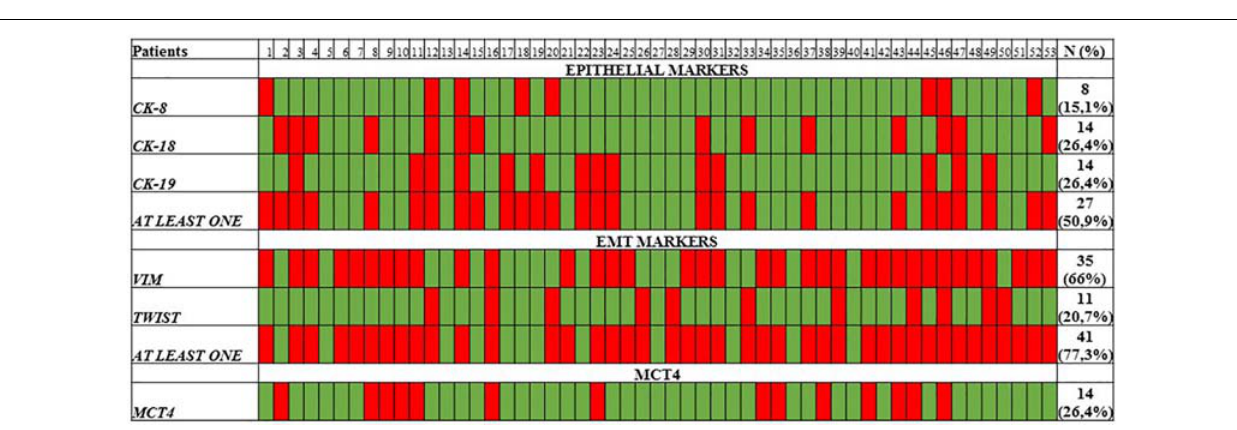
FIGURE 2 | Heat map of CK-8/CK-18/CK-19 epithelial markers, VIM , TWIST-1, and MCT4 as quantified by